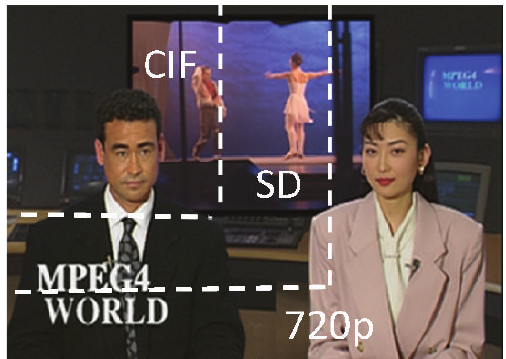
Figure 2: Defining ROIs with different spatial resolutions (e.g., CIF, SD/4CIF, 720 p resolutions) to be provided within a Scalable Video Coding